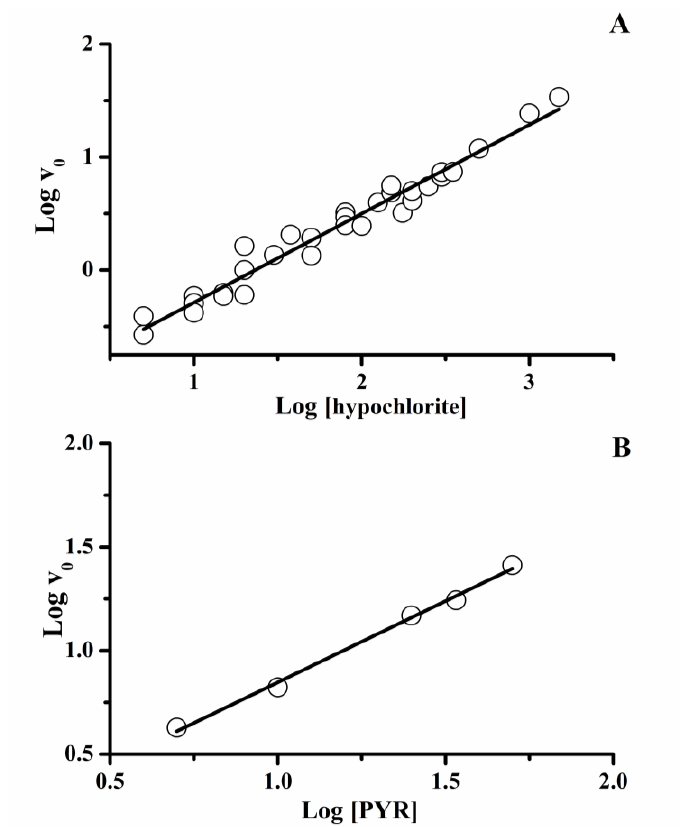
Figure 4. Dependence of initial consumption rate of PYR with hypochlorite ( A ) or PYR initial concentrations ( B ). Log-Log